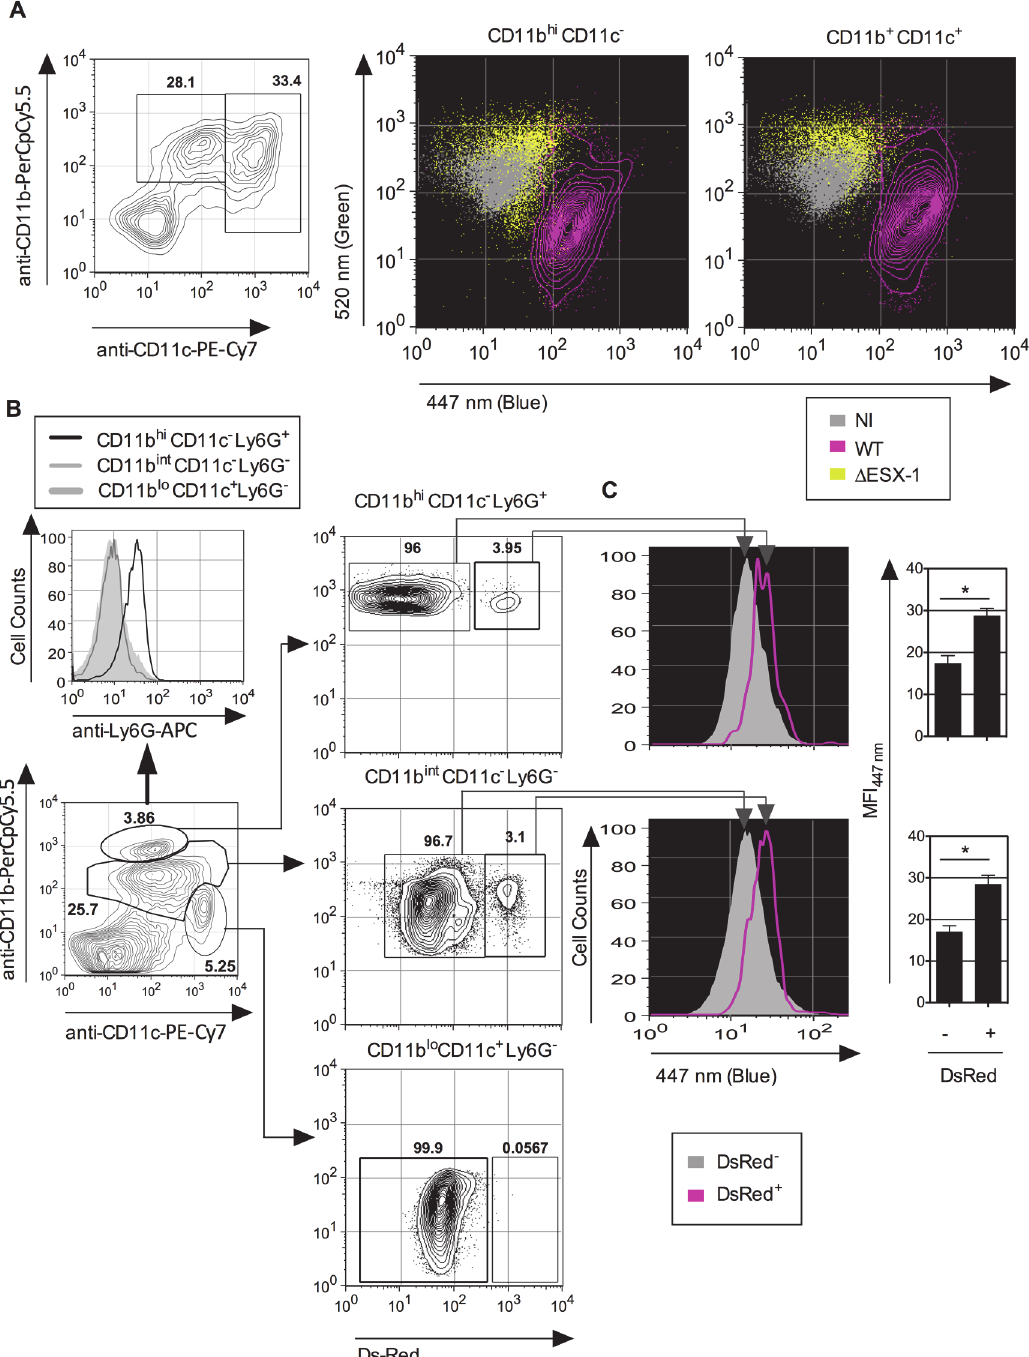
Fig 6. Mtb -mediated phagosomal rupture in different cell subsets ex vivo and in vivo . (A) Low-density cells were isolated from C57BL/6 mouse lung parenchyma and infected ex vivo with WT or Δ ESX-1 Mtb (MOI = 1). Monocytes/M Φ (CD11b + CD11c - ) and DC (CD11b int CD11c + ) were assessed for CCF-4 signals at 4 dpi. (B) Phagosomal rupture detected in vivo in different Mtb -infected phagocyte subsets. C57BL/6 mice ( n = 3) were injected i.v. with 1 x 10 6 CFU of DsRed WT Mtb and at 3 weeks post infection. Alive low-density cells were isolated on Optiprep gradient from the spleen and were sequentially stained with CCF-4 and a cocktail of mAbs to distinguish neutrophils (CD11b hi CD11c - Ly6G + ), M Φ /monocytes (CD11b int CD11c - Ly6G - ) or DC (CD11b lo CD11c + Ly6G - ). (C) Inside each innate cell subsets, the blue CCF-4 signals of the DsRed + and DsRed - cells were compared together. The results are representative of 2 independent experiments.